Question: Write a descriptive caption for this figure.
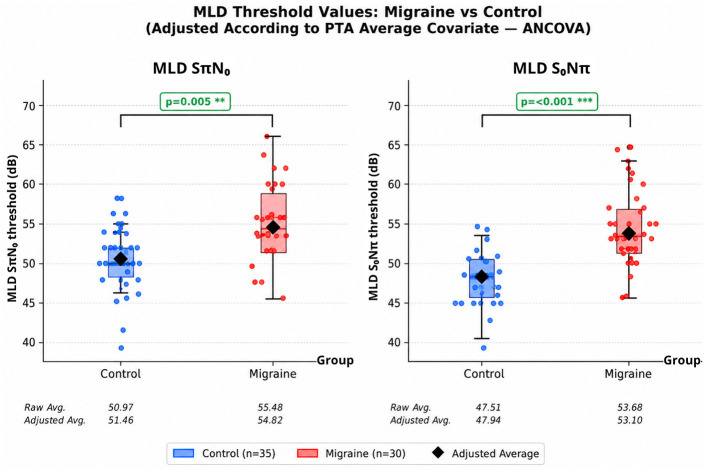
Answer: Distribution of MLD SπN 0 and MLD S 0 Nπ thresholds in the migraine and control groups after adjustment according to PTA Average Covariate- ANCOVA [Boxes: interquartile range (IQR); central lines: medians; whiskers: 1.5 × IQR; individual points: raw measurements; diamonds: ANCOVA-adjusted values].